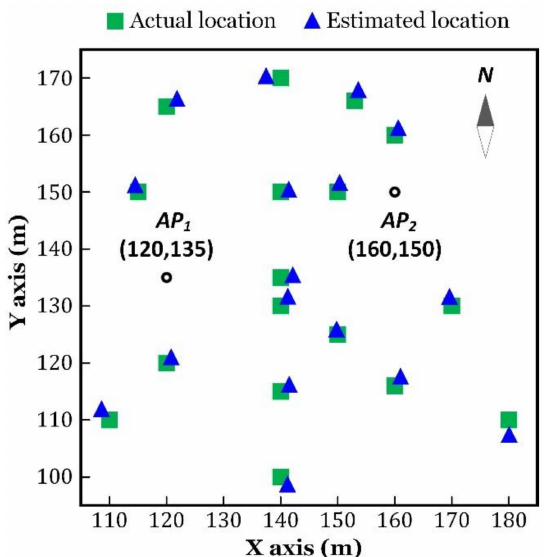
Figure 10. Indoor localization results.